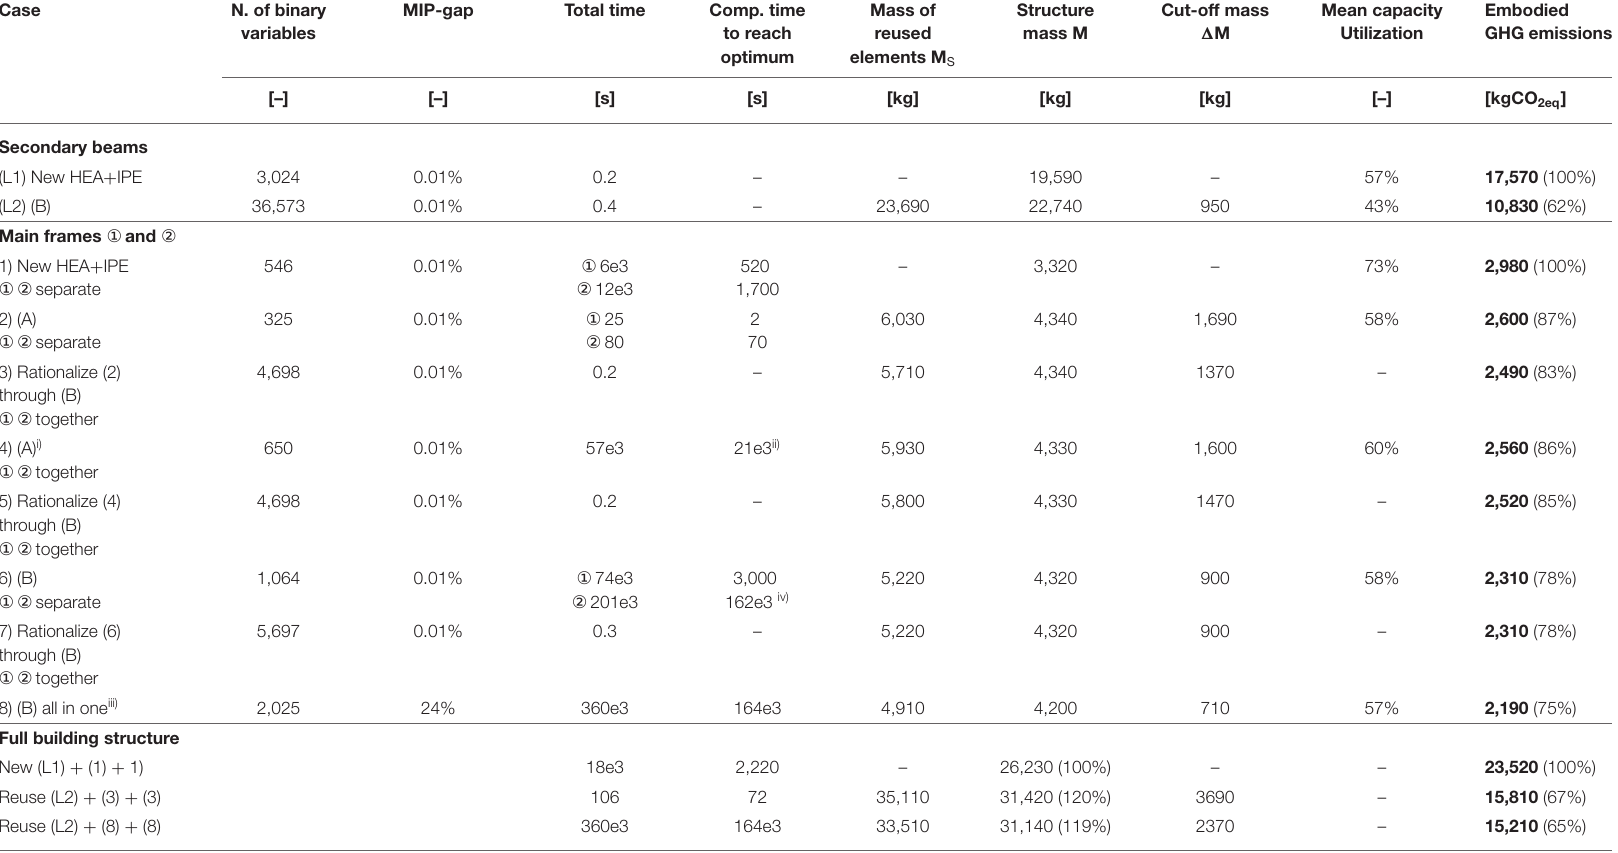
TABLE 5 | Optimization results for office